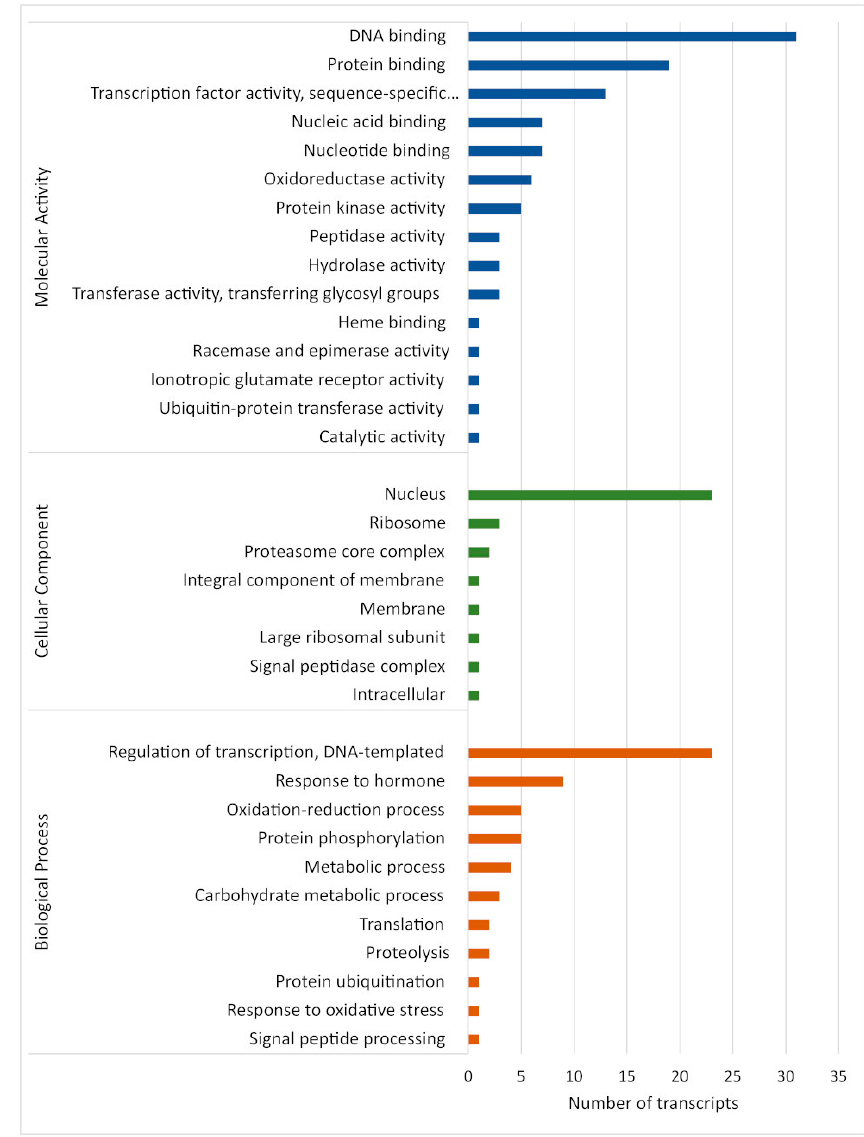
Figure 6. Distribution of enriched gene ontology (GO) terms for gene targets of Musa acuminata var. Calcu tt a 4 miRNAs.